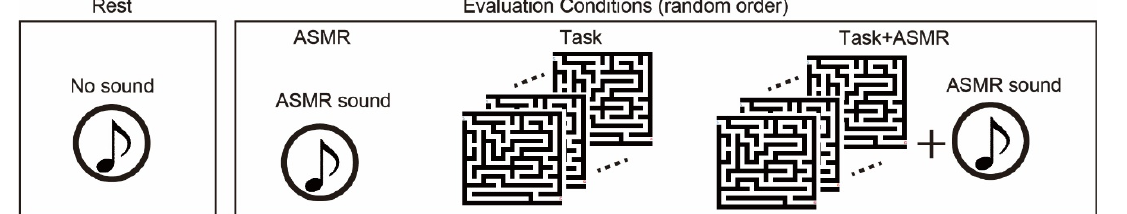
Figure 2. Experimental condition for evaluation of the effect of ASMR on the mental stress. We use resting condition(rest), and three types of evaluation condition: sole application of ASMR sound (ASMR), sole application of maze tasks (Task), and simultaneous application of maze task and ASMR sound (Task + ASMR). NASA-TLX is performed after Task and Task + ASMR. Duration of all of condition is 3 min. The evaluation conditions are assessed in random order.